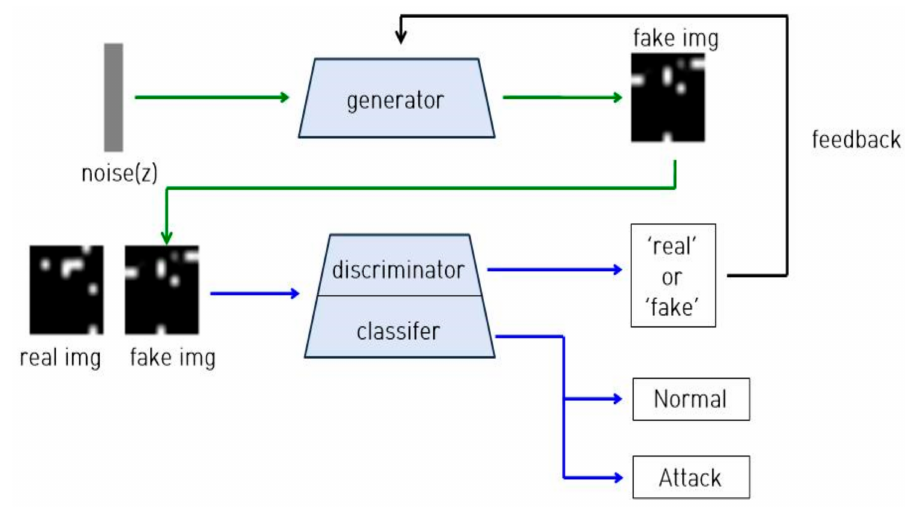
Figure 4. Training of the classification model.